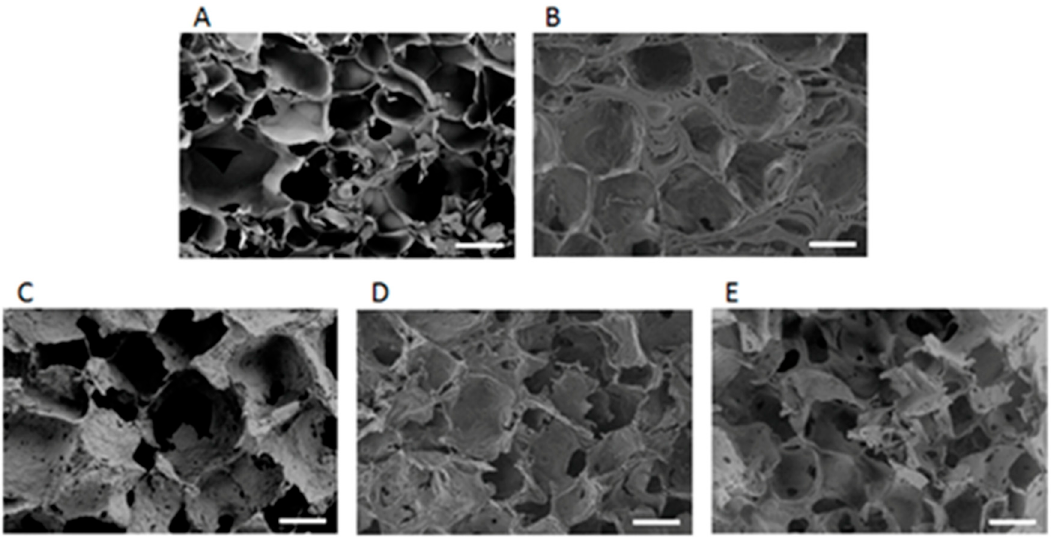
Figure 2. The cross-section scanning electron microscope (SEM) images of hydrogels. ( A ) S100; ( B ) P100; ( C ) P25/S75; ( D ) P50/S50; ( E ) P75/S25. Scale bars = 100 μ m.